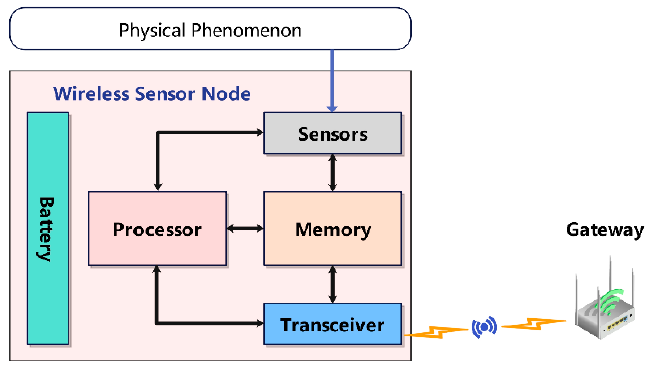
Figure 3. Wireless data acquisition devices.